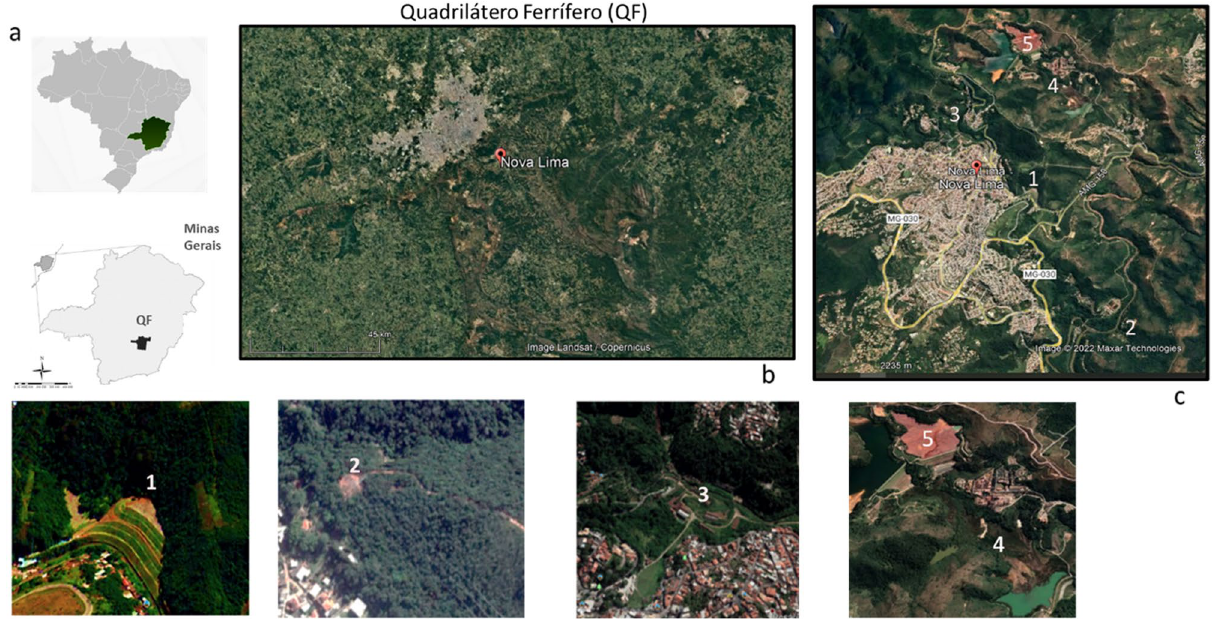
Figure 1. Location of the QF ( a ), Nova Lima Region and the location in the QF ( b ), and the illustration location of the tailings deposit 1 to deposit 5. Google earth Pro V 7.3.6.9345 (64-bit). Image date 6/22/2022 19° 59 ′ 05.66 ″ S and 43° 50 ′ 49.070 ″ W. The dams and mine dumps in this region are located between the cities of Nova Lima and Raposos, 25 km from its capital, Belo Horizonte, Minas Gerais, Brazil ( c ).